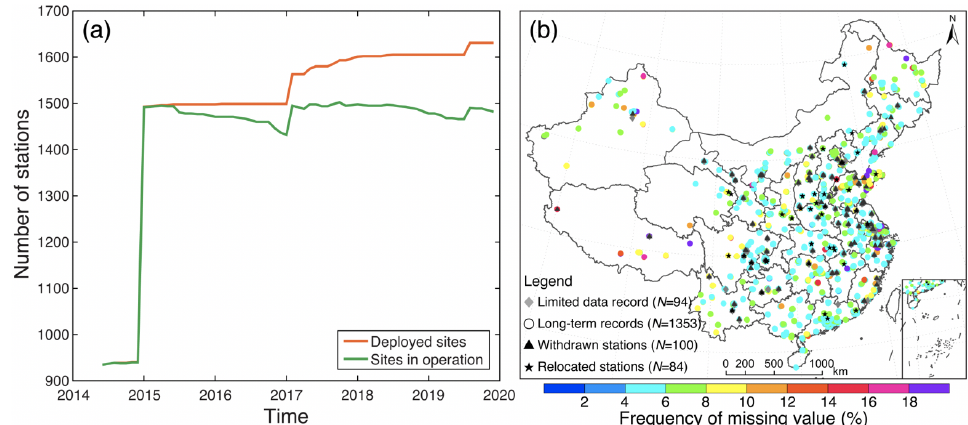
Figure 2. Spatial and temporal patterns of air quality monitoring stations in the study area. (a) Temporal variations of the total number of air quality monitoring stations. (b) Spatial patterns of the frequency of missing values in each long-term hourly PM 2 . 5 concentration record measured from 1 January 2015 to 31 December 2019. Stations were categorized into distinct groups according to their data length and temporal continuity. The frequency of missing values was calculated as the ratio of the number of missing values in each PM 2 . 5 concentration record to the total number of samplings from the time of the release of the first valid data to 31 December